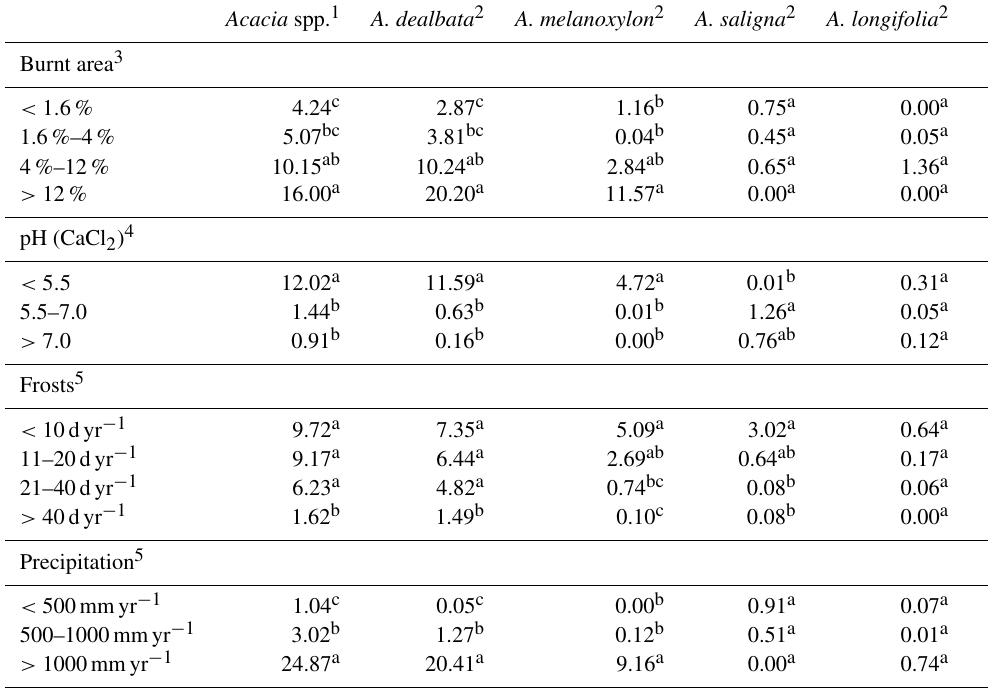
Table 4. Acacia presence frequency (percentage of occupied area) depending on site characteristics. For each species and site characteristic, different letters show significant differences (a > b > c, p < 0 . 05; test for equality of percentages of Sokal and Rohlf,